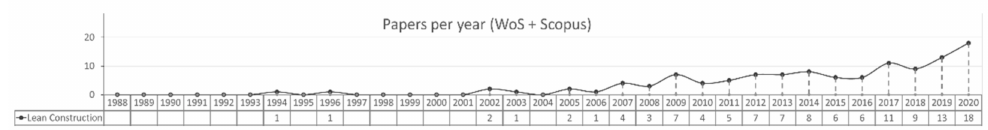
Figure 10. Lean construction